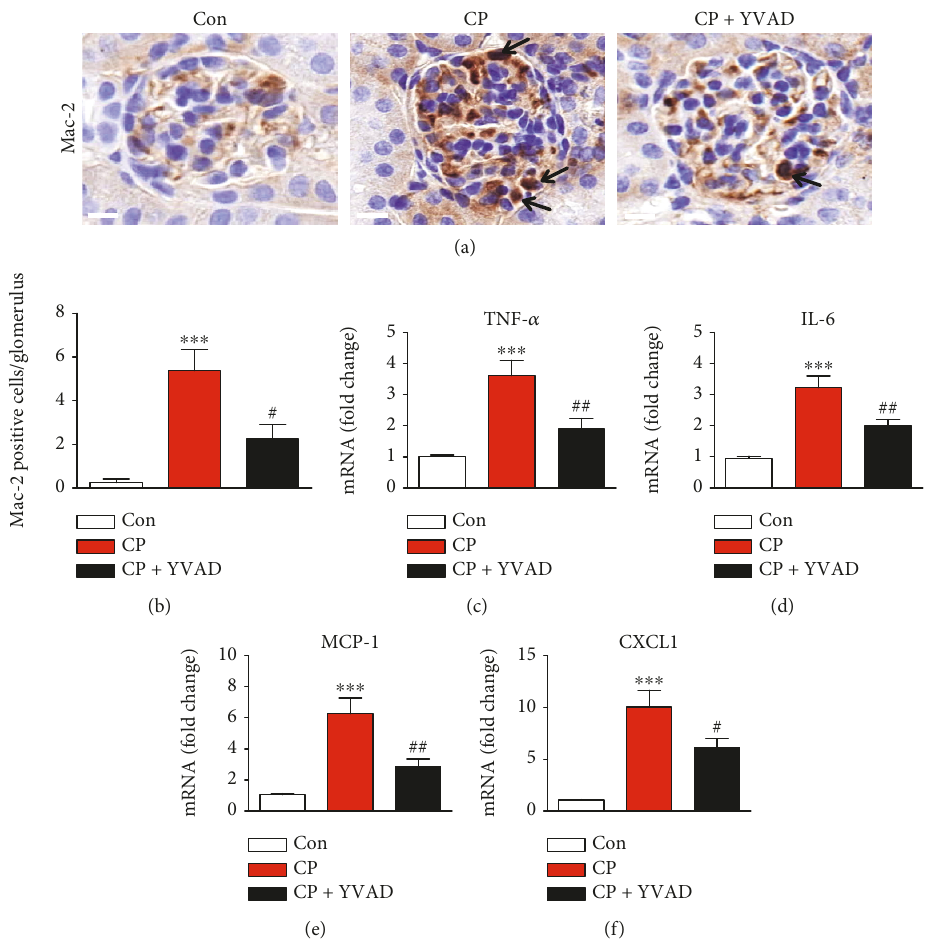
Figure 5: E ff ects of Ac-YVAD-cmk on cisplatin-induced in fl ammatory responses. (a) Representative images of immunohistochemical staining using anti-Mac-2 antibody in the glomerulus. Black arrows indicate Mac-2 positive cells. Scale bar: 25 μ m. (b) Percentage of Mac-2 positive cells per glomerulus. Real-time RT-PCR analysis of TNF- α (c), IL-6 (d), MCP-1 (e), and CXCL1 (f) in the kidneys. Con: control, CP: cisplatin, and CP +YVAD: cisplatin plus Ac-YVAD-cmk. n = 8 per group. All data are expressed as the mean ± SEM. ∗∗∗ P < 0 001 vs. Con. # P < 0 05 and ## P < 0 01 vs.